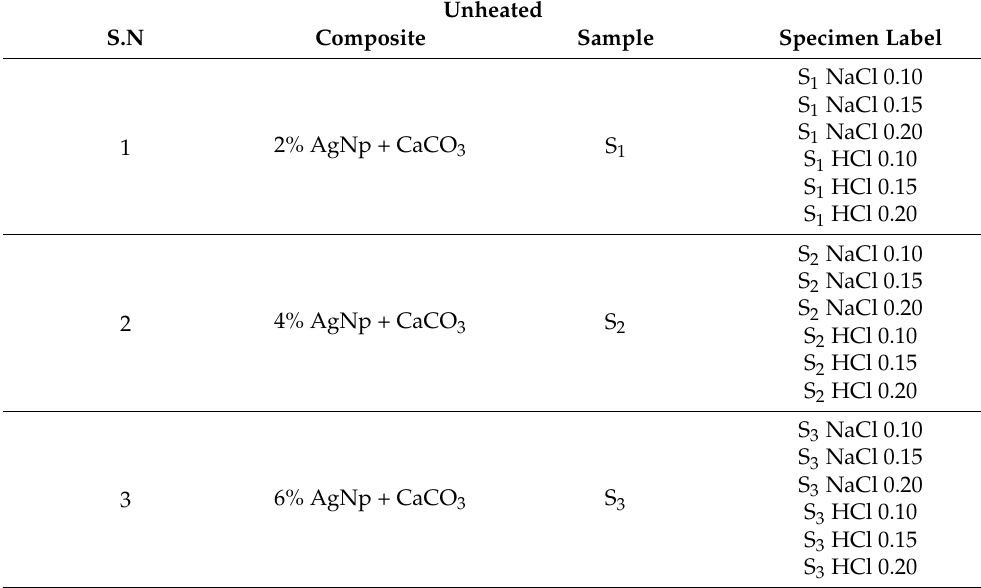
Table 2. Unheated AgNp + CaCO 3 sample notation.